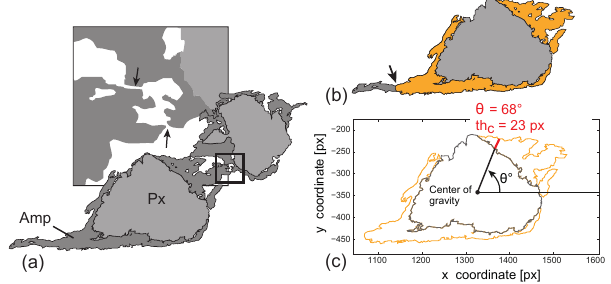
Figure 1. Analysis of amphibole corona thickness. (a) Digital phase map of segmented pyroxene (Px) clasts and associated amphibole (Amp) coronas. Where adjacent coronas are in contact, they are sep- arated manually (close-up, black arrows). (b) Long “tails” of Amp growing in low stress sites around clasts are eventually “cut” (black arrow) if they extend too far away from the clast. (c) Corona thick- ness, thc( θ ), is determined from the polar coordinates of the aggre- gate and clast outline as a function of the angle θ (0 ◦ < θ < 360 ◦ ), with θ running counterclockwise from the